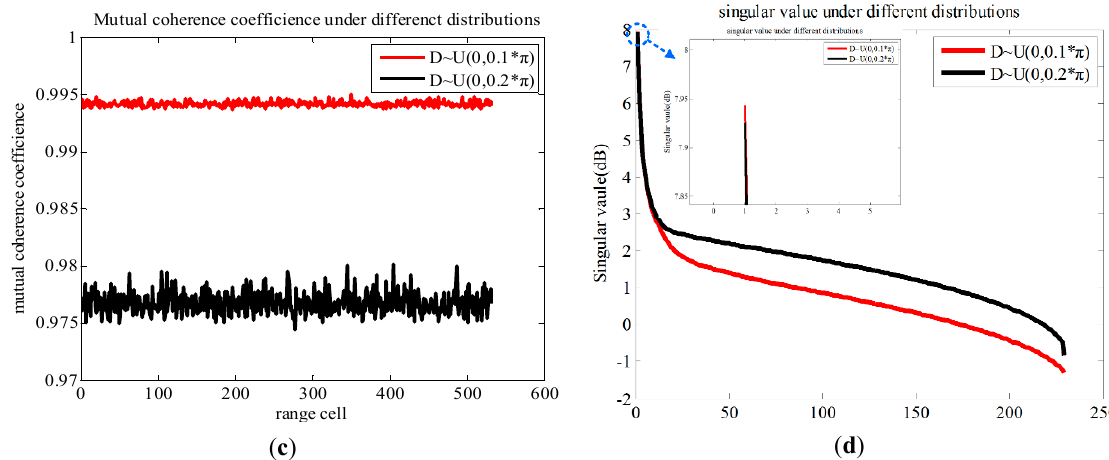
Figure 9. Simulated results of reconstructed scene, mutual coherence coefficient, singular value, and singular channel capacity, respectively. After pseudo-random space-time modulation, results (a) and (b) are successfully reconstructed with sub-Nyquist samples compared to Figure 1d. Results (a) and (b) are simulated when the phase of pseudo-random space-time modulation obeys a uniform distribution with different variances. Results (c) and (d) denote the curves of mutual coherence coefficient, and singular value amplitude under two distributions.